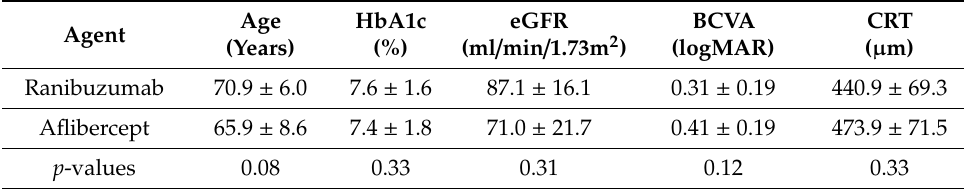
Table 1. Patients’ backgrounds.